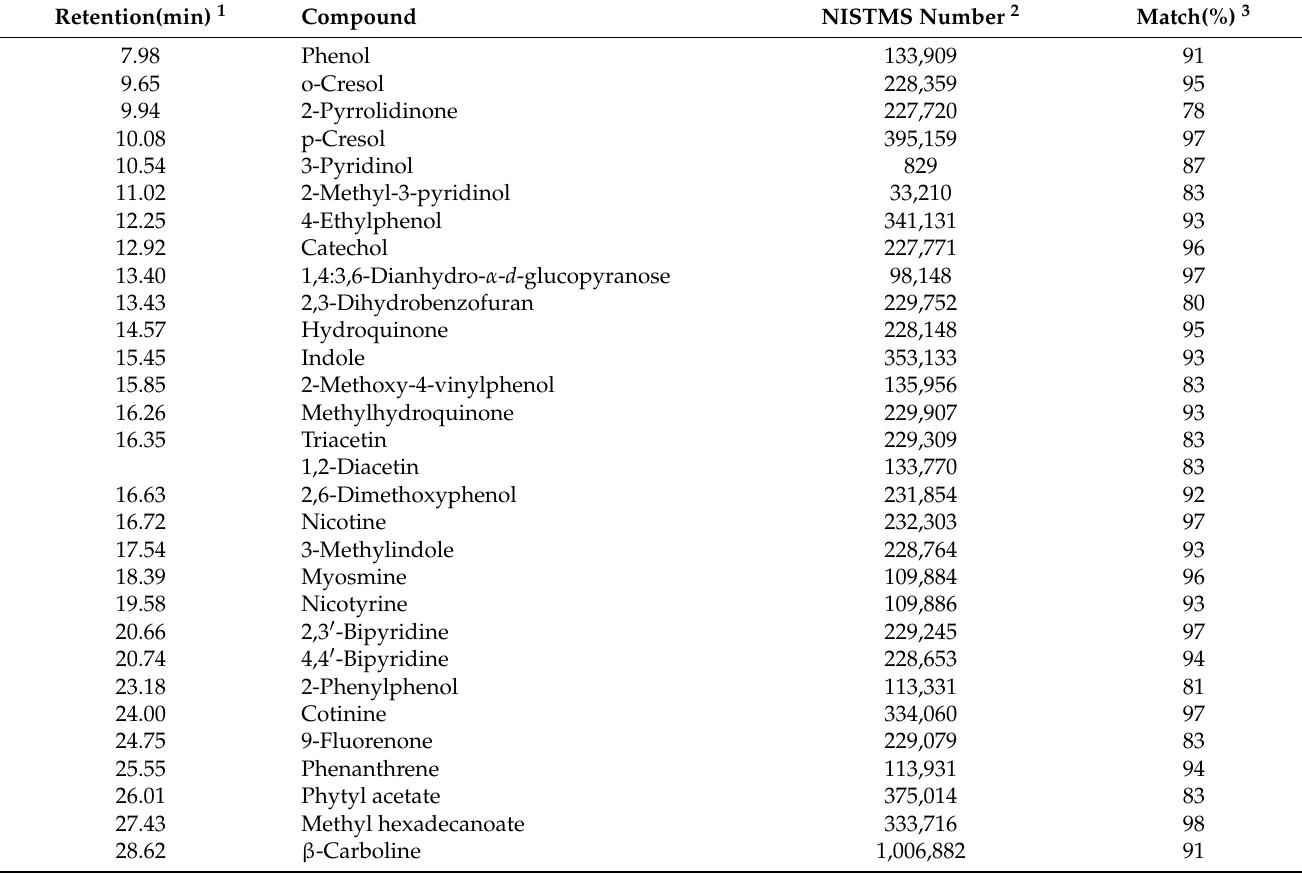
Table 1. Preliminary chemical identification by GC-MS and mass spectral